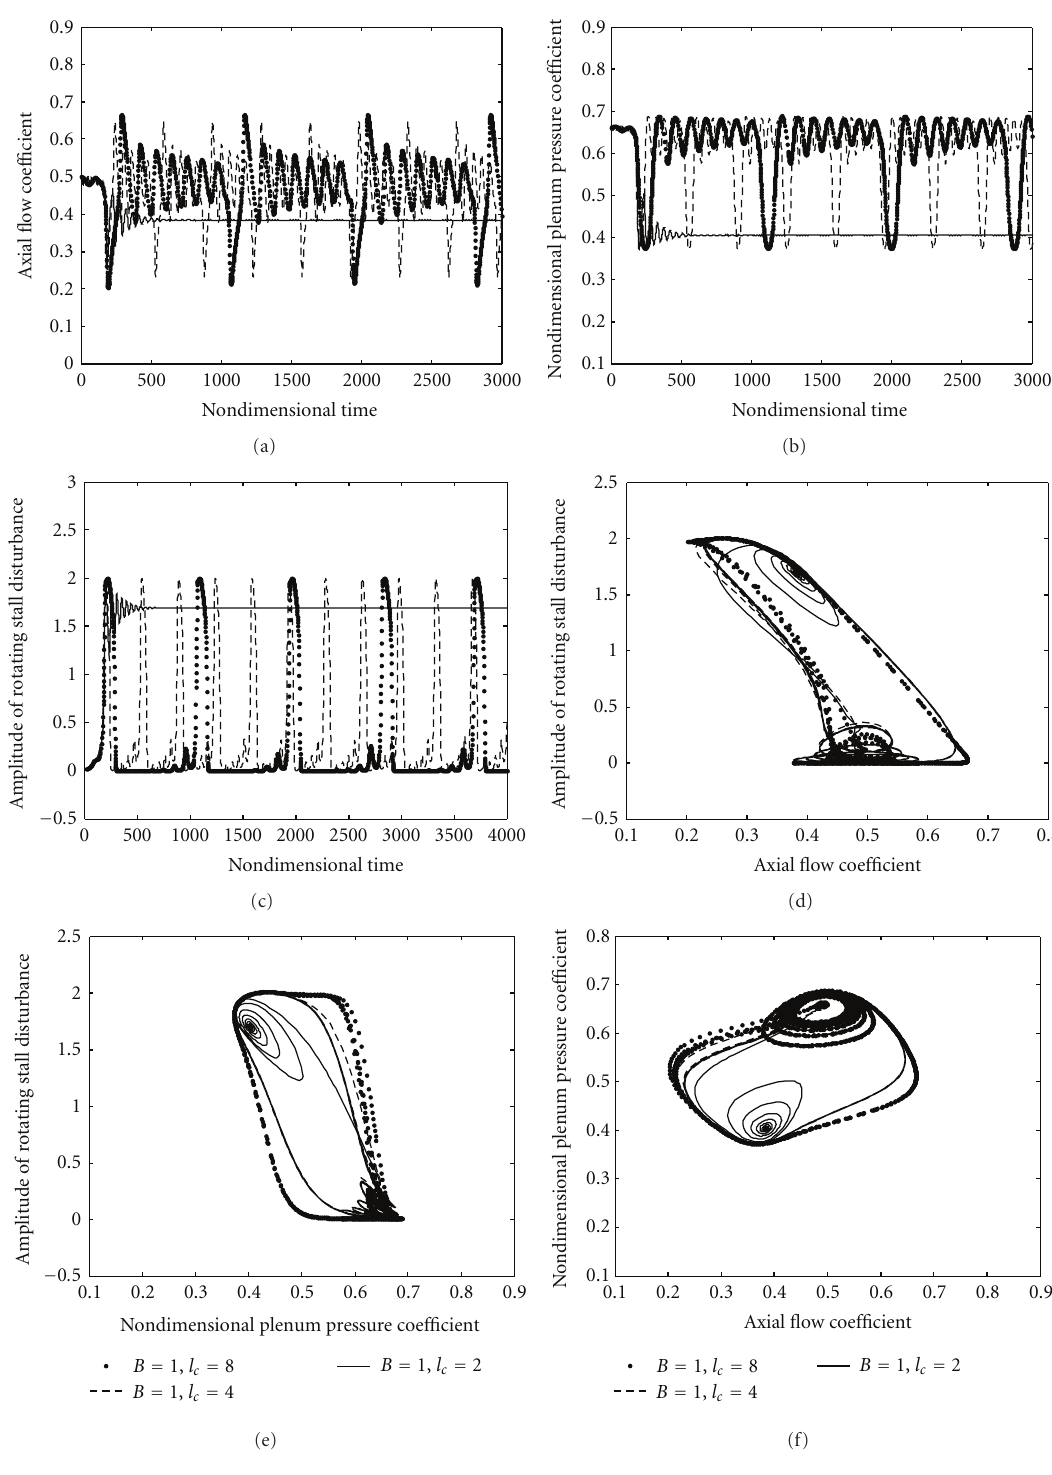
Figure 11: E ff ect of increase in mean annulus area of compressor: variation of nondimensional flow properties (a), (b), and (c) with time. (a) Axial flow coe ffi cient, (b) plenum pressure rise coe ffi cient, and (c) disturbance amplitude of rotating stall. (d) Variation of axial flow coe ffi cient with disturbance amplitude of rotating stall. (e) Variation of plenum pressure rise coe ffi cient with disturbance amplitude of rotating stall. (f) Limit cycle oscillation: axial flow coe ffi cient versus plenum pressure rise coe ffi